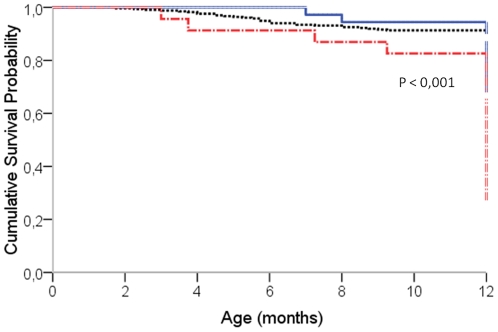
Cumulative Survival rates of children by 12 month according to mode of feeding, Cameroon.Taking in consideration defined feeding practice variables, survival curves by one year of age in each group were estimated using Kaplan Meier method. Next, survival curves between mixed-fed children (lower survival curve) and their counterpart exclusive formula-fed (middle survival curve) or exclusive breastfed (upper survival curve) were compared using the log-rank test.